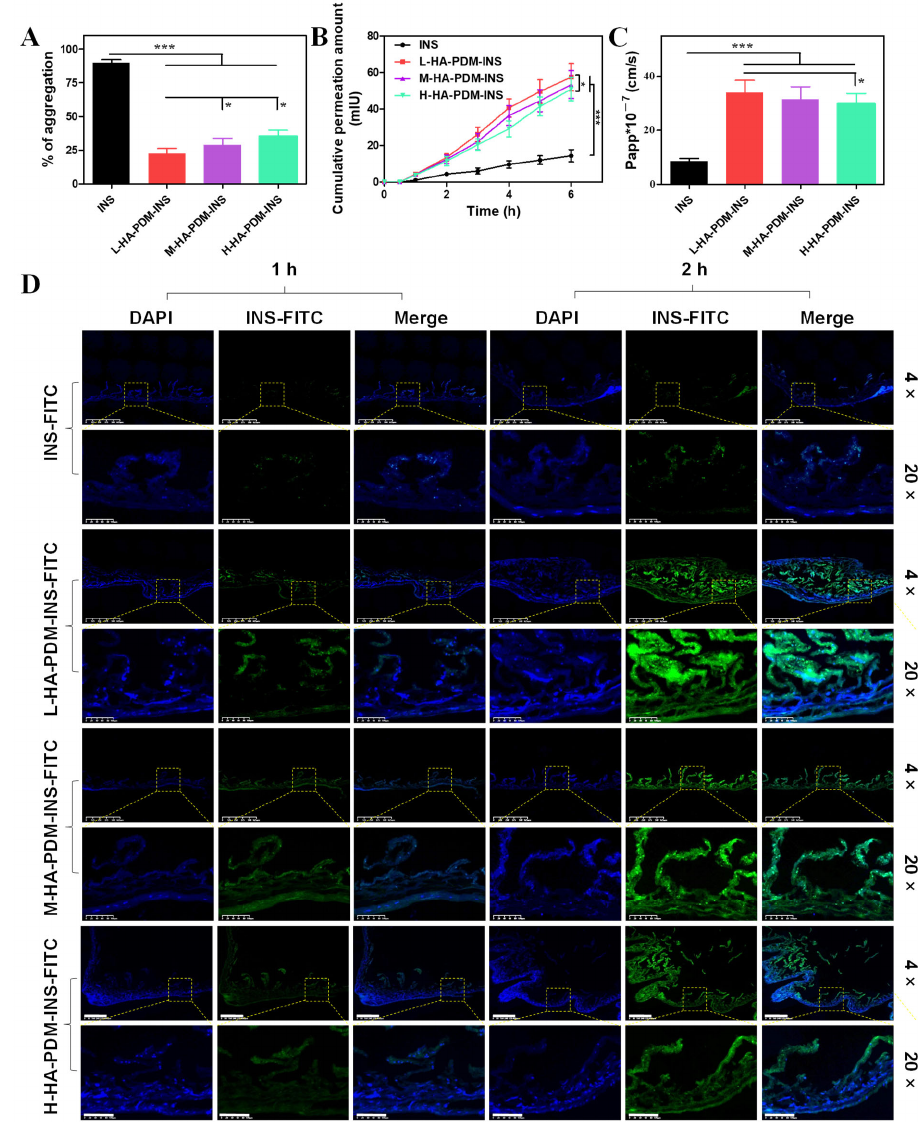
Figure 6. ( A ) Aggregates of free insulin, L ‐ HA–PDM–INS, M ‐ HA–PDM–INS, H ‐ HA–PDM–INS, and mucins (X ± SD, n = 6, * p < 0.05, *** p < 0.001). ( B ) Permeation studies of insulin from L ‐ HA–PDM–INS, M ‐ HA–PDM–INS, and H ‐ HA–PDM–INS across the intestinal loops (X ± SD, n = 6, * p < 0.05, *** p < 0.001). ( C ) Apparent permeability coefficient (Papp) of insulin across isolated intestinal sections (X ± SD, n = 6, * p < 0.05, *** p < 0.001). ( D ) Confocal micrographs of the small intestinal villi sections after incubated with different formulations for 1 and 2 h, scale = 100 μ m.